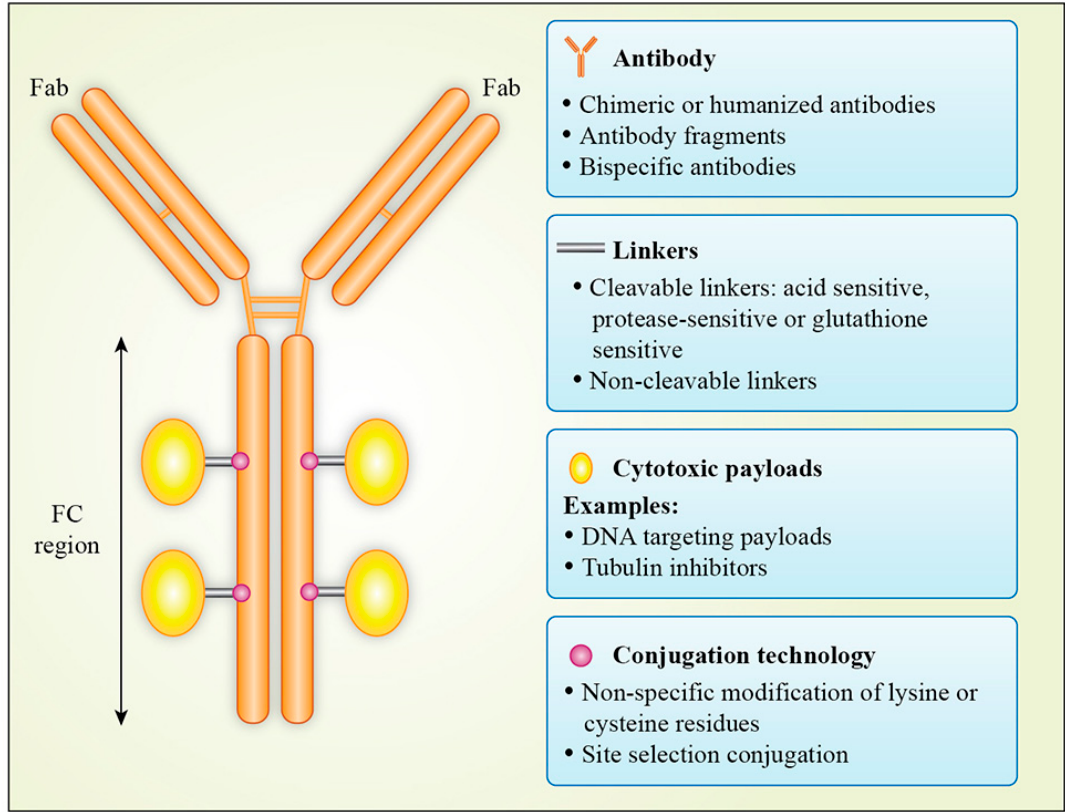
Figure 1. Antibody–drug conjugate structure.